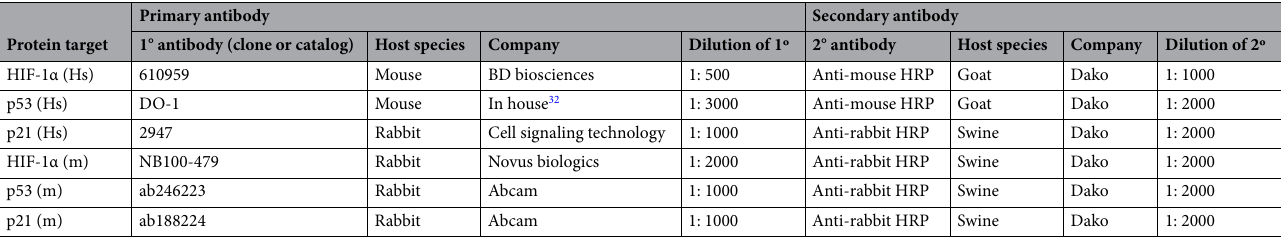
(Fig. 1d–f), confirming the wildtype p53-dependent mechanism of action of the inhibitors. Together, these find- ings indicate that the potencies of nutlin-3a and navtemadlin are not significantly affected in hypoxic conditions, and they confirm that nutlin-3a is less potent than navtemadlin in normoxia and hypoxia. To determine whether the reduction in growth resulted from fewer proliferating cells, we then measured the uptake of 5-ethynyl-2’-deoxyuridine (a marker of DNA synthesis) in cells treated with MDM2 inhibitors for 24 h 6,31 in normoxia or hypoxia. In HCT116 p53 +/+ cells, treatment with both inhibitors in normoxia led to